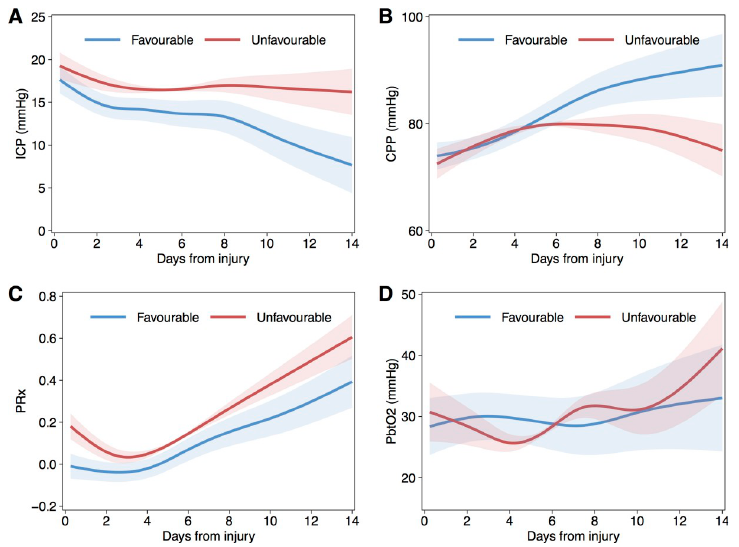
Fig 3. Fitted population mean time courses for intracranial pressure derived parameters and brain tissue oxygenation. Temporal course fitted with generalised additive mixed models (GAMM), by dichotomised Glasgow Outcome Score group. ICP (A), CPP (B), PRx (C), and PbtO 2 (D), Shaded areas indicated 95% confidence intervals.